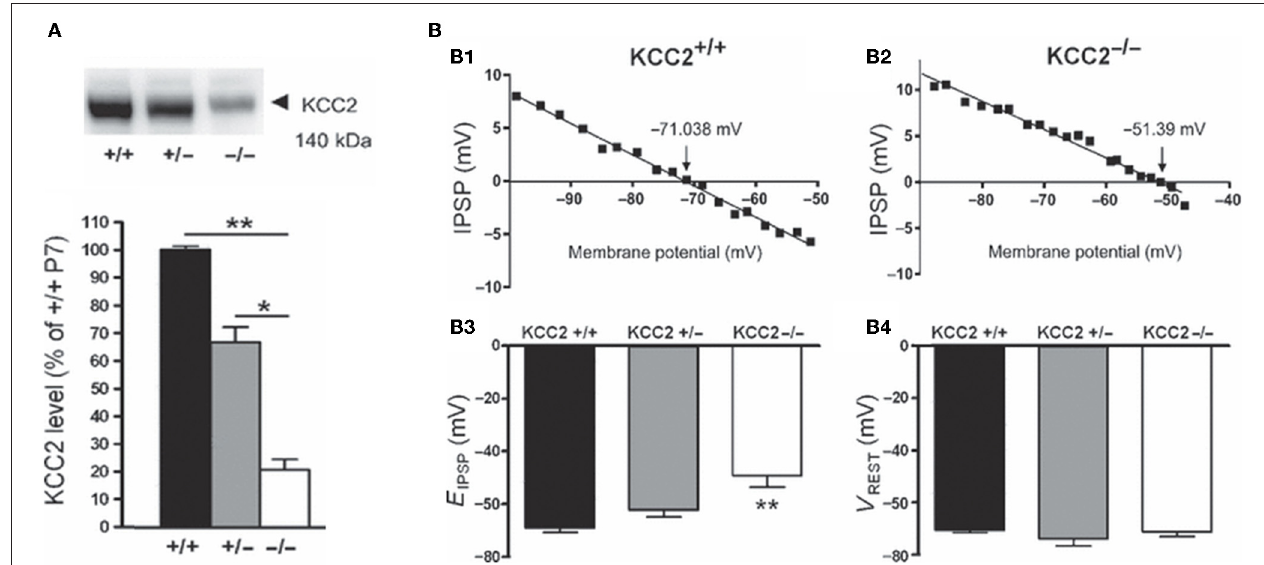
FIGURE 6 | The depolarizing action of GABA correlates with in vivo KCC2 expression. (A) Western blot analysis of KCC2 expression in the lumbar spinal cord at postnatal day 7 ( ∼ 140kDa). The KCC2 expression is significantly reduced in KCC2b − / − mice. (B) Reversal potentials of IPSPs in lumbar MNs of wild-type and KCC2 mutant mice at postnatal day 5–7.